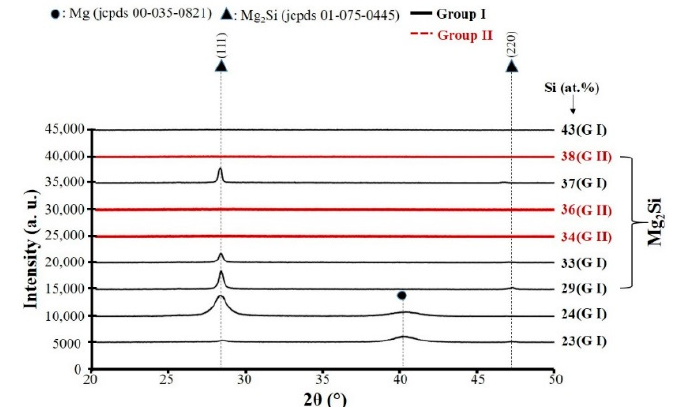
Figure 2. X-ray diffraction patterns of as-deposited Mg–Si thin films on glass slide substrate (Group I: R P < 7 × 10 − 4 Pa black lines and Group II: R P ≥ 7 × 10 − 4 Pa red lines). (Selected zone indicates the X-ray diffraction patterns of the films with the composition closed to Mg 2 Si).